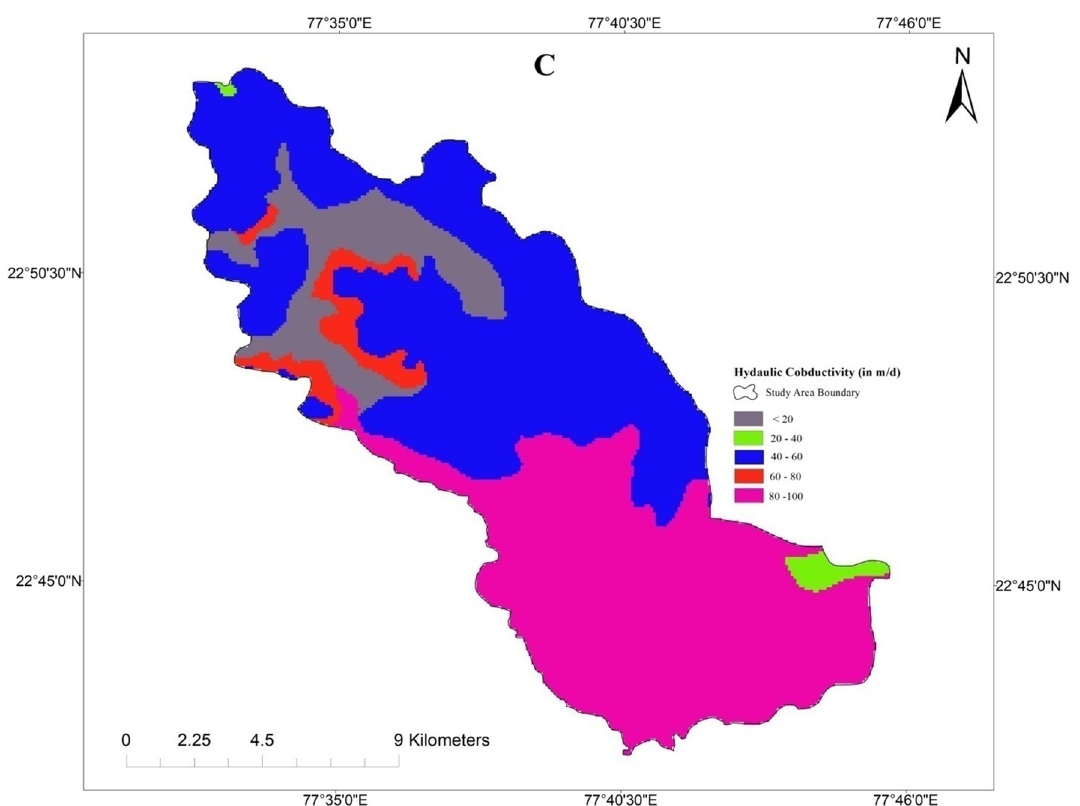
Fig. 9 Hydraulic